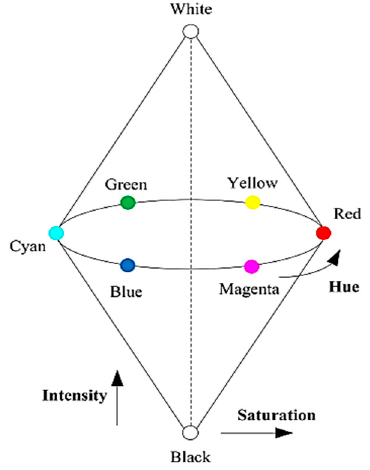
Figure 7. HSI Figure 7. HSI coordinates.